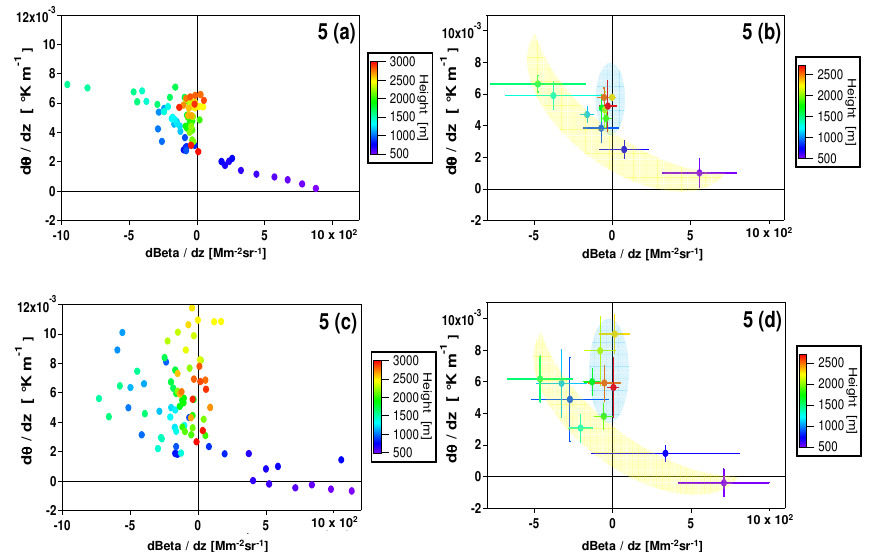
Fig. 5. Relationship between the first derivatives as a function of the height of aerosol backscatter (Beta) and potential temperature ( θ) vertical profiles: (a) by using the points from 500m to 3000m a.g.l. (30m vertical resolution) of one pair of Beta and θ vertical profiles obtained by averaging 14 available profile pairs; (b) by averaging the points of (a) every 200m with the error bars indicating ± 1 standard deviation of the means; (c) by using the points from 500m to 3000m a.g.l. (30m vertical resolution) of one pair of Beta and θ vertical profiles obtained by averaging a subset of 4 profile pairs; (d) by averaging the points of (c) every 200m with the error bars indicating ± 1 standard deviation of the means. Yellow and blue coloured areas in (b) and (d) indicate the SML + DRCL and the free troposphere,